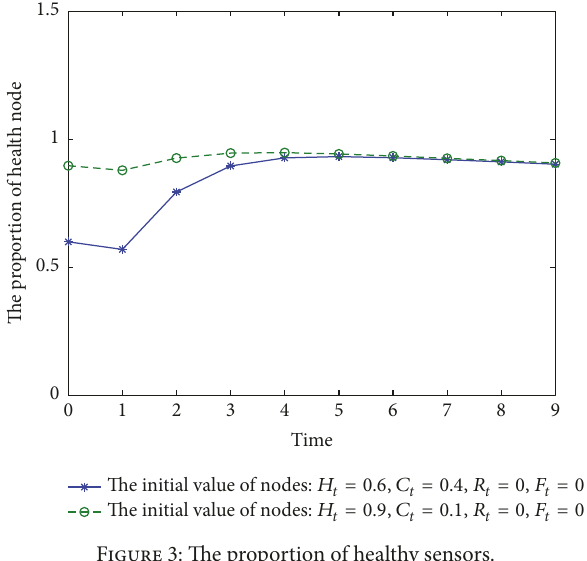
Figure 5: The proportion of responsive sensors.